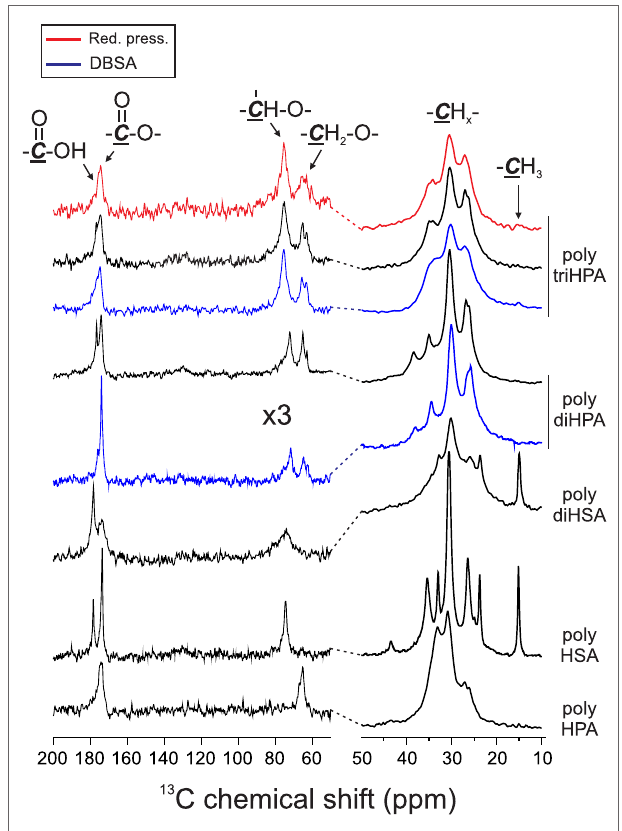
FigUre 2 | solid state 13 c Mas-nMr spectra of polyesters . For clarity, the intensity of the 50–200 ppm region is multiplied by a factor of